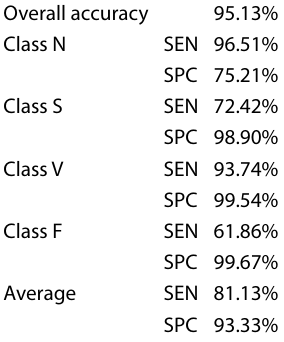
Table 6 Performance of our classifier for Patient Specific/ Patient-oriented data